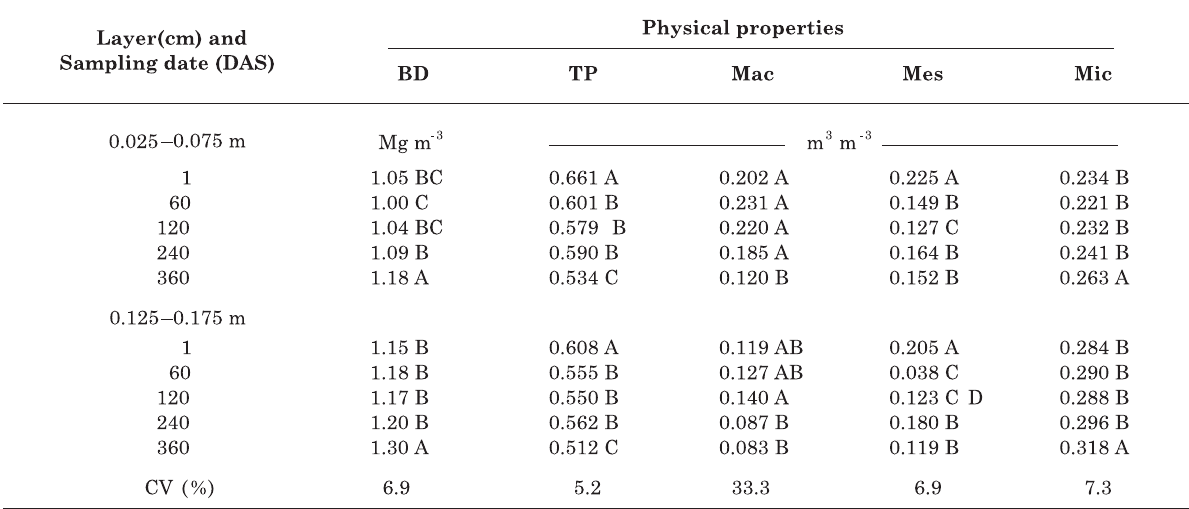
Table 2. Physical properties determined in two layers at five sampling dates in the tenth year (averaged across tillage systems)